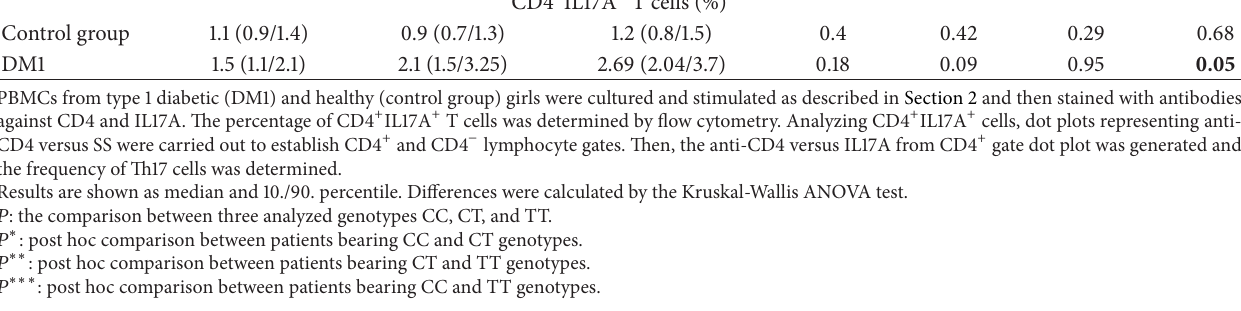
Table 4: Flow cytometric analysis of CD4 + IL17A + T cells in girls differing in the IVS1 − 397T > C estrogen receptor 𝛼 polymorphism.